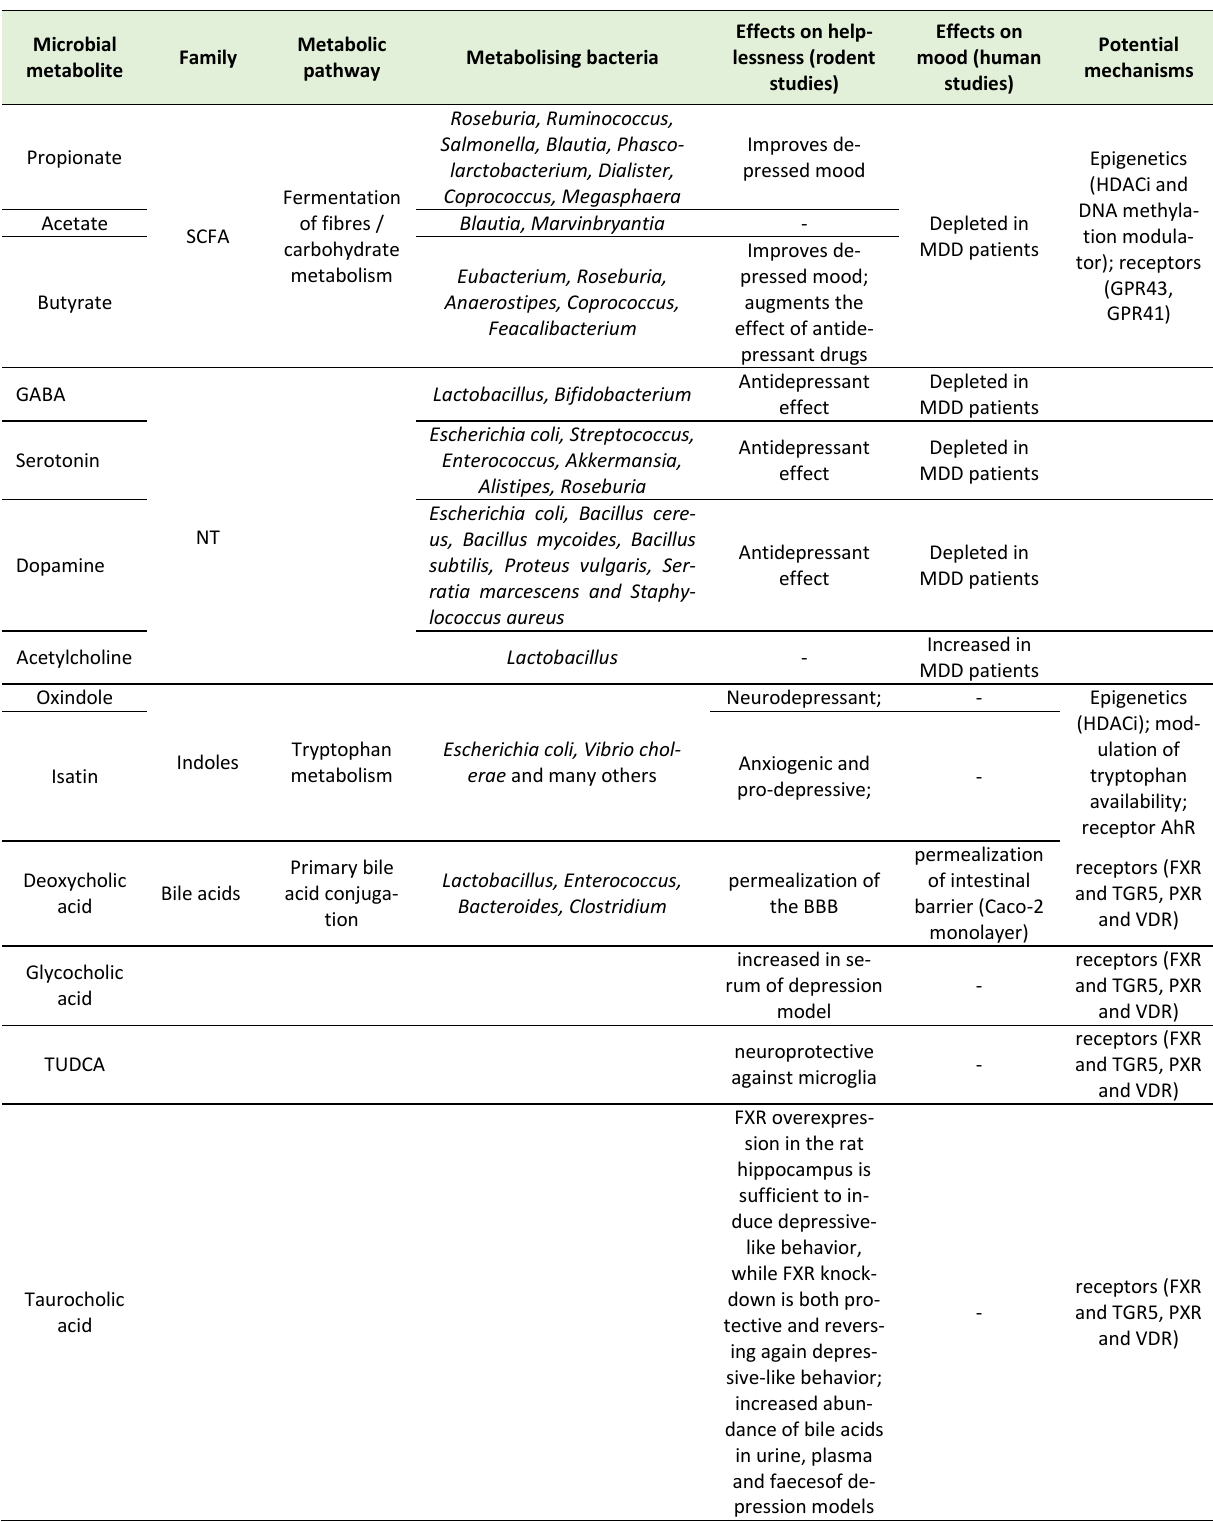
TABLE 9. Effects of microbial metabolites on depressive behavior in rodent and human studies.